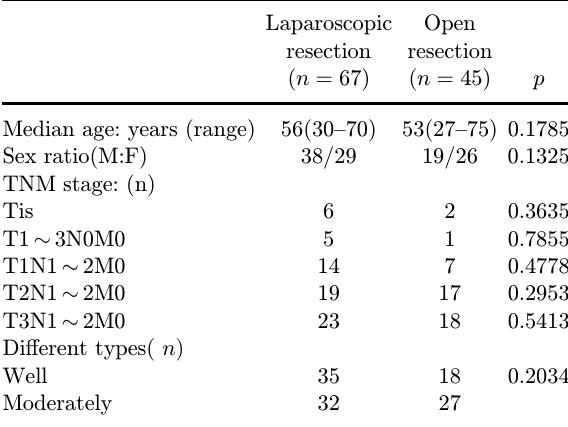
Table 1. Clinical and demographic characteristics of patients undergoing laparoscopic or open resection of low/ ultralow rectal cancer.